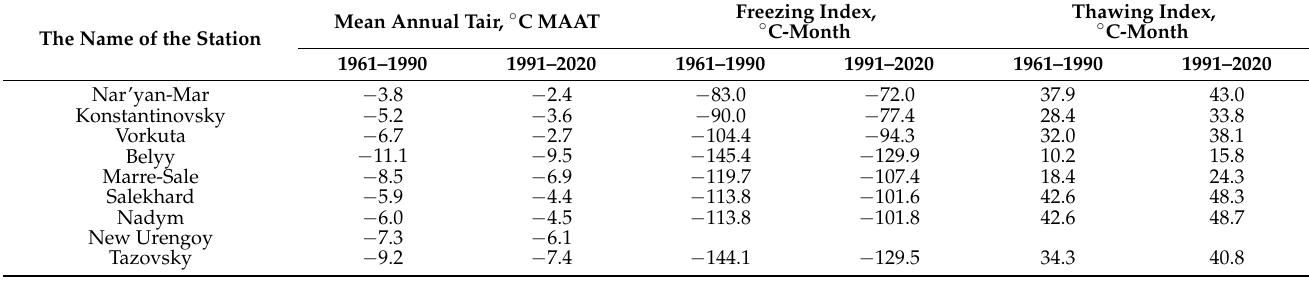
Table 2. Climatic indicators for reference weather stations.